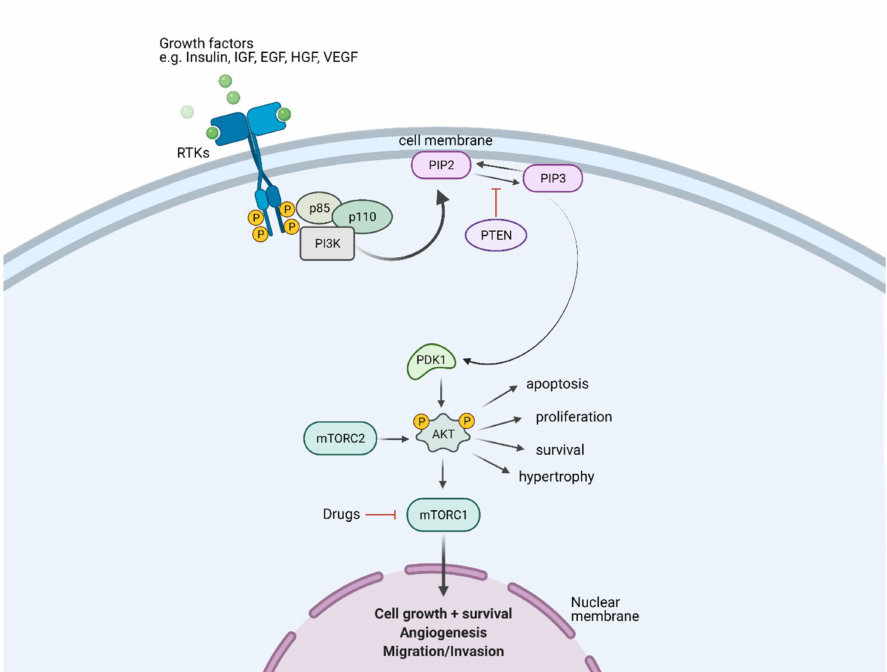
Figure 1. Schematic diagram illustrating the PI3K/AKT/PTEN/mTOR signaling pathway in a cell. A ligand-engaged RTK binds PI3K either directly or indirectly, removing the inhibitory action of its p85 subunit on the catalytic p110 subunit. In physiological conditions, growth factors stimulate PI3K, which subsequently phosphorylates the phospholipid substrate PIP 2 to generate the second messenger PIP 3 . PIP 3 recruits and activates several functional targets, such as AKT isoform, PDK1, and others. The lipid phosphatase PTEN converts PIP 3 to PIP 2 , which terminates accentuation of the growth signal to maintain normal cellular and tissue homeostasis. RTKs, receptor tyrosine kinases; IGF, insulin-like growth factors; EGF, epidermal growth factor; HGF, hepatocyte growth factor; VEGF, vascular endothelial growth factor; PTEN, phosphatase and tensin homolog; PI3K, phosphoinositide 3-kinase; PIP 2 , phosphatidylinositol 4,5-bisphosphate; PIP 3 , phosphatidylinositol 3,4,5-trisphosphate; PDK1, phosphoinositide-dependent kinase-1; AKT, protein kinase B; mTORC1, mammalian target of rapamycin complex 1. The figure was created with BioRender.com (accessed on 14 February 2022) and was exported under a paid